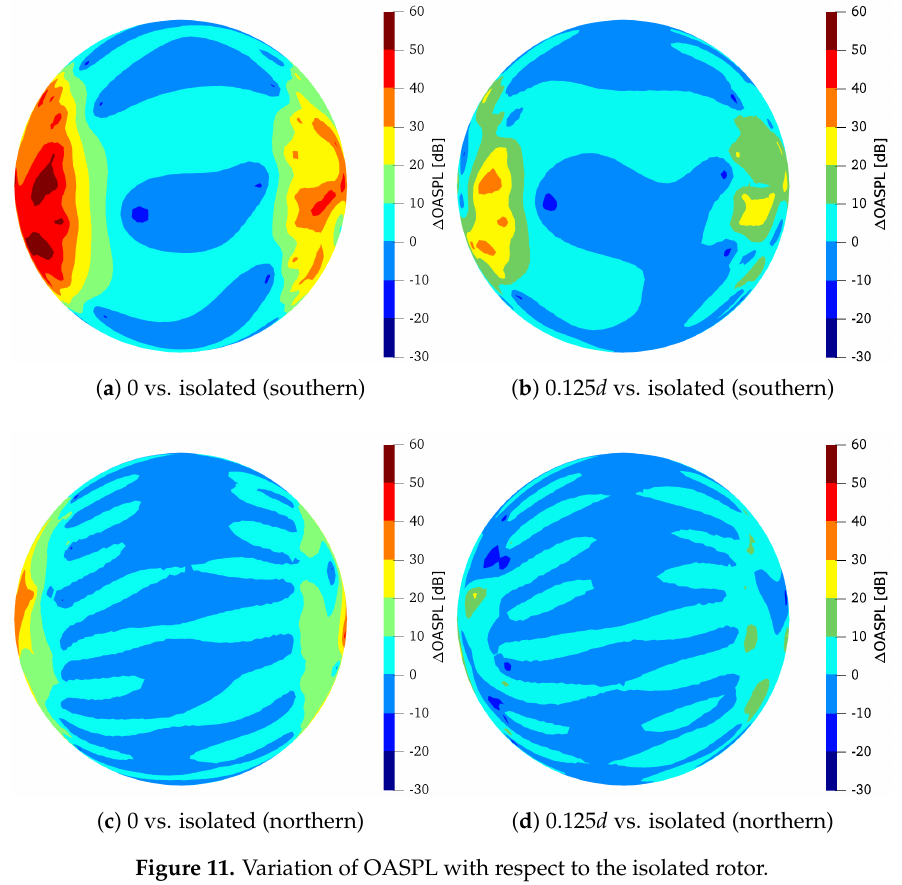
Figure 11. Variation of OASPL with respect to the isolated rotor.